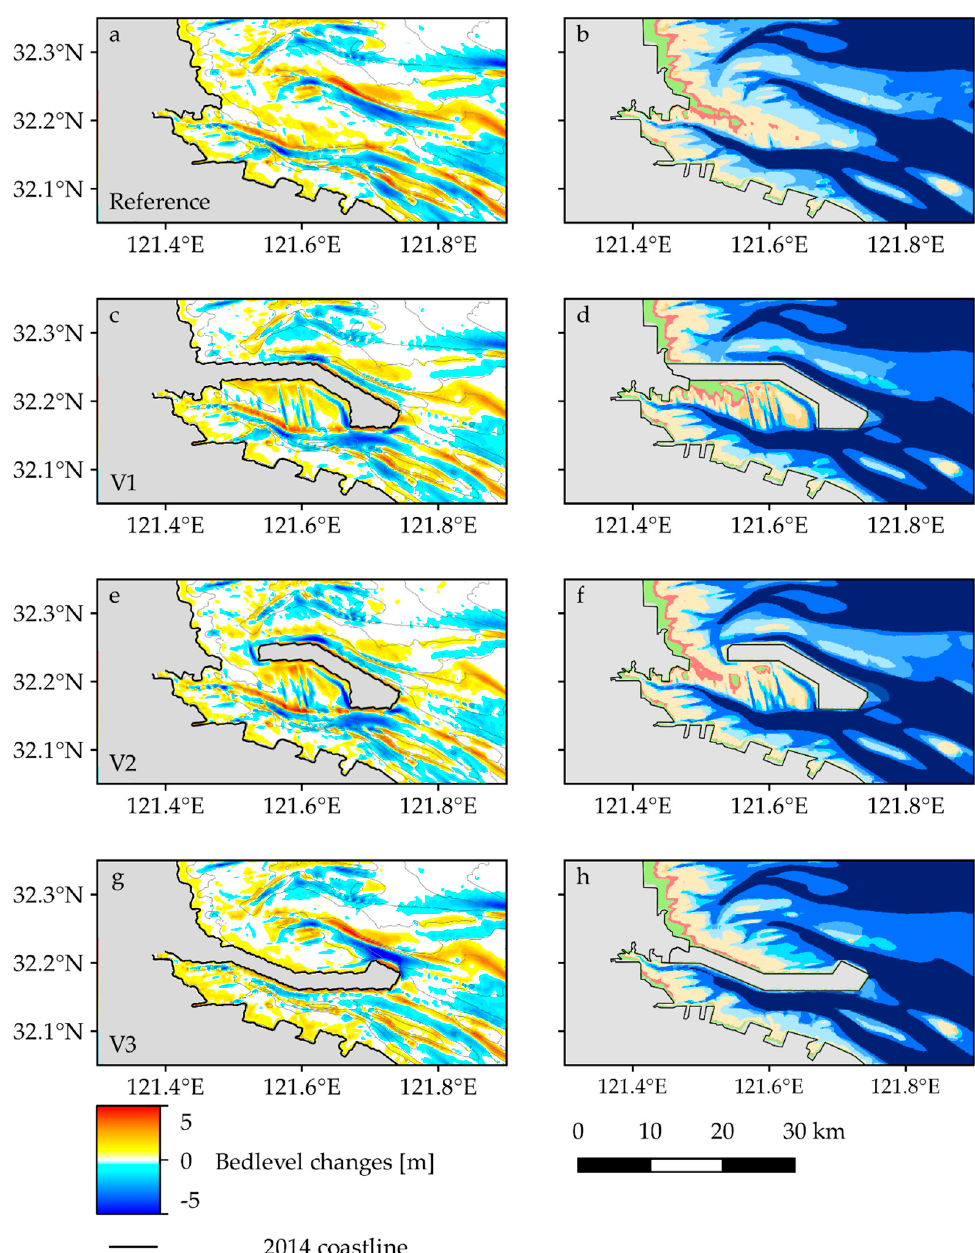
Figure 10. Left: Total siltation for 20 years of morphological development without further reclamations ( a ) and configuration v1 ( c ), v2 ( e ) and v3 ( g ). Right: Ecotope distribution after 20 years of development for the reference case ( b ) and configuration v1 ( d ), v2 ( f ) and v3 ( h ).